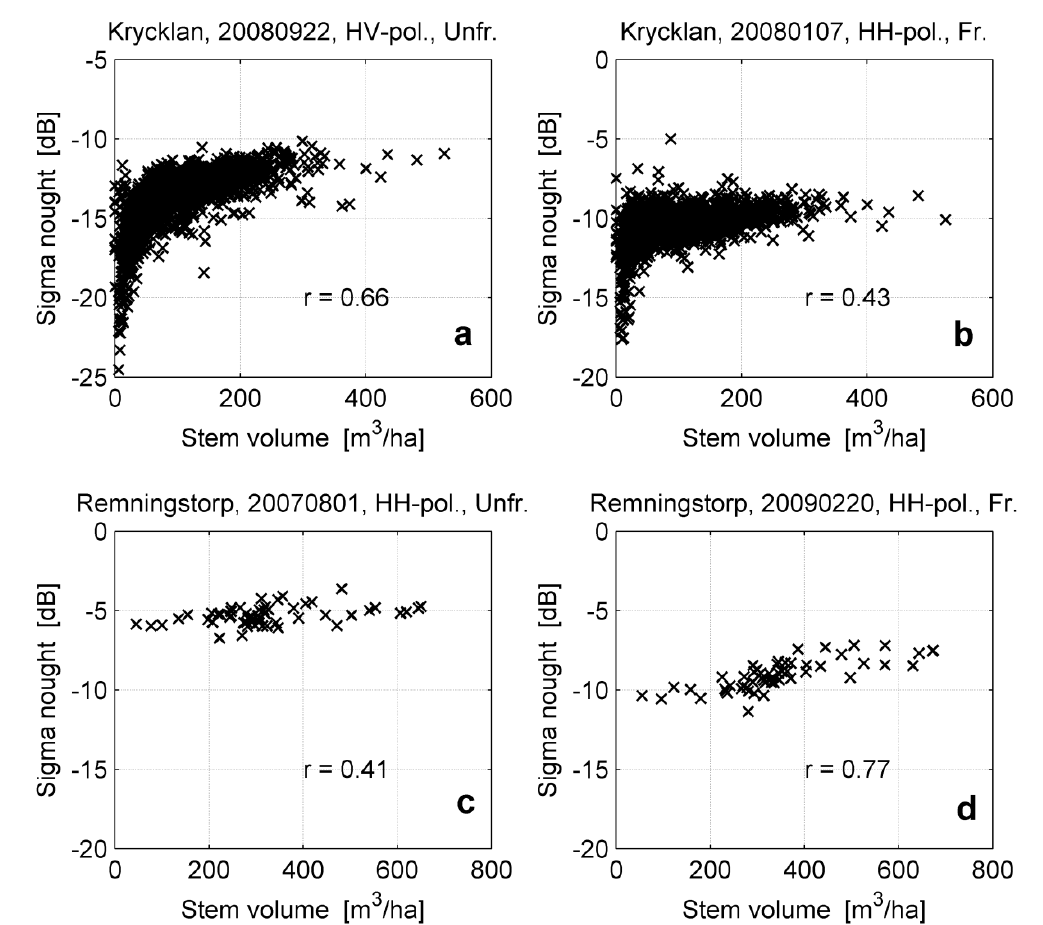
Figure 3. Panels ( a ) and ( b ) illustrate data from Krycklan. Panels ( c) and (d) illustrate data from Remningstorp. SAR backscatter with respect to stem volume for unfrozen (Unfr.) conditions (panels (a) and (c)) and frozen (Fr.) conditions (panels (b) and (d)) with among the highest correlation coefficients (see Table 5). Look angle: